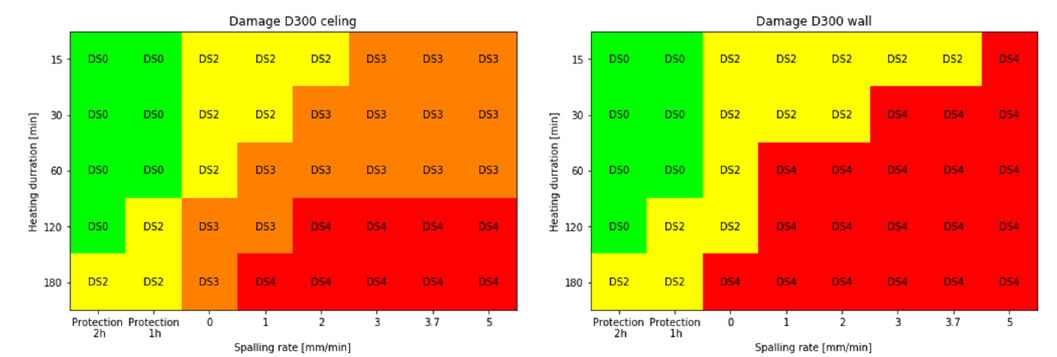
Figure 7. Thermal damage state (ceiling and wall) in function of RWS heating phase duration and nominal rate of concrete spalling.